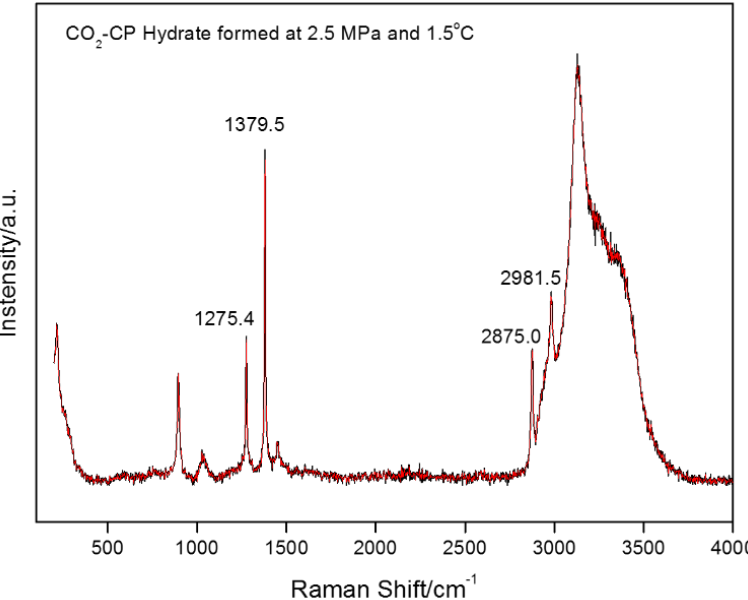
Figure 13. Raman spectrum of hydrate formed from CO 2 -CP system at 2.5 MPa and 1.5 °C.